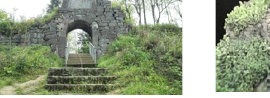
Figure 20 . 3D printed model of Erdao Gate, Hailongtun.